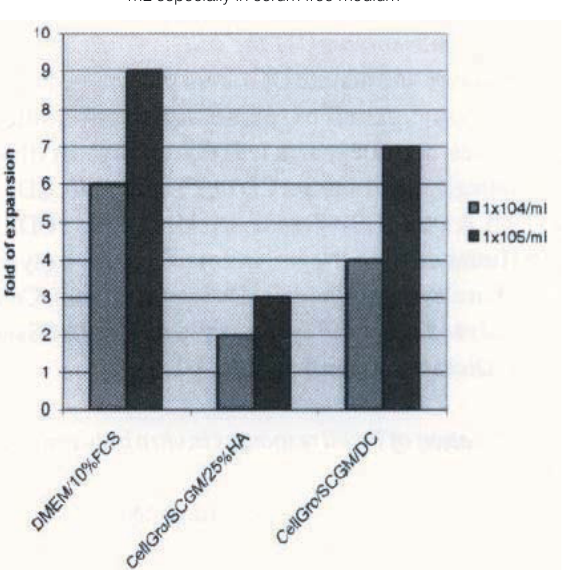
Figure 1. CD34+ cells (three different samples) cultured in serum- free CellGro SCGM/DC medium with added cytokines (as shown in materials and methods). The graphs indicate the fold expansion over time.